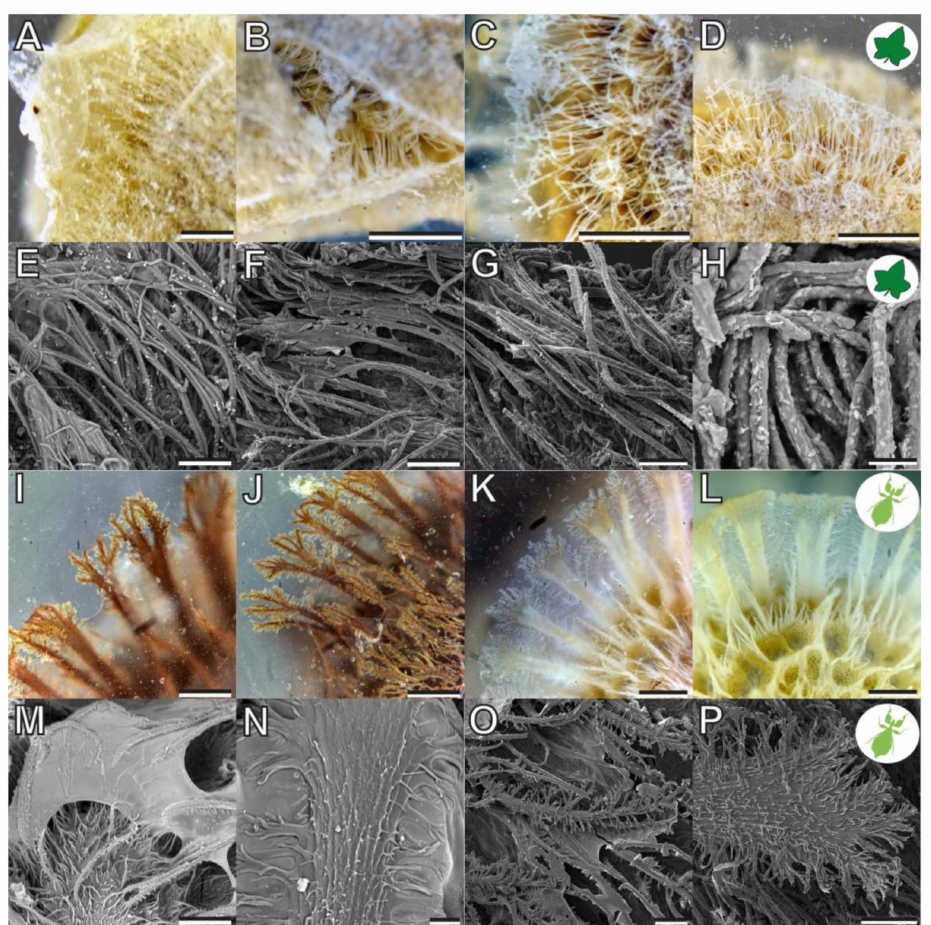
Figure 4. Morphology of the fas in the corresponding reproductive stages of the focal species. ( A – H ) Coccinia grandis seed. ( I – P ) Phyllium philippinicum egg. ( A – D , I – L ) Photographs of glue and fas interactions. ( E – H , M – P ) SEM of the glue and the fas morphology. Scale bars: ( A – D , I – L ) 300, ( E – G , N , O ) 50, ( H ) 20, ( M ) 150, and ( P ) 100 µ